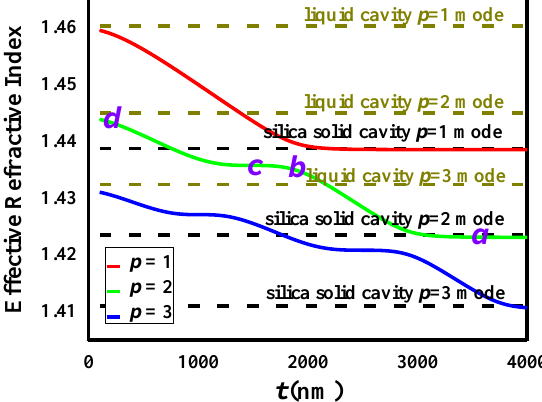
Figure 2. The whispering gallery mode (WGM) electromagnetic field distribution of the p = 2 mode for various shell thickness (gray shadow). ( a ) 3.5 μm. ( b ) 2 μm. ( c ) 1.5 μm. ( d ) 0.2 μm.